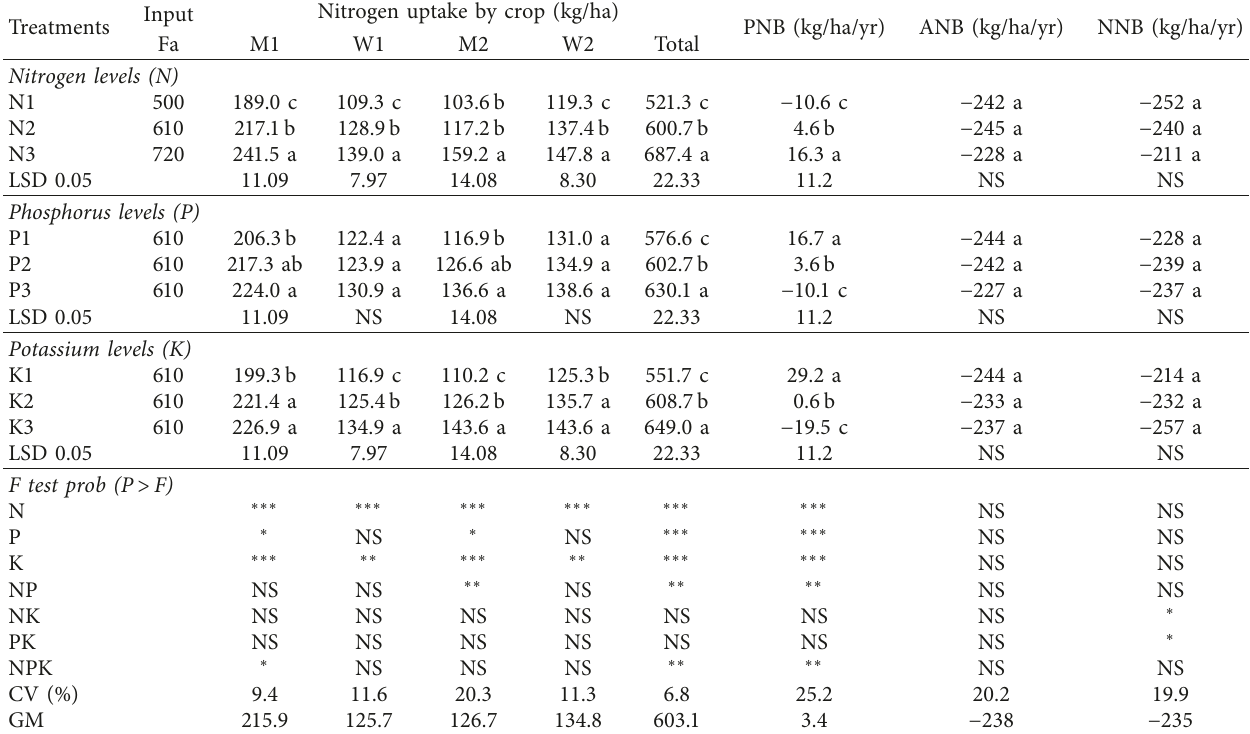
Table 3: Partial balance, apparent gain or loss, and net gain or loss of nitrogen (kg/ha) per year as affected by fertilization in the maize-wheat experiment, Khumaltar, Lalitpur, 2019/20–2020/21.